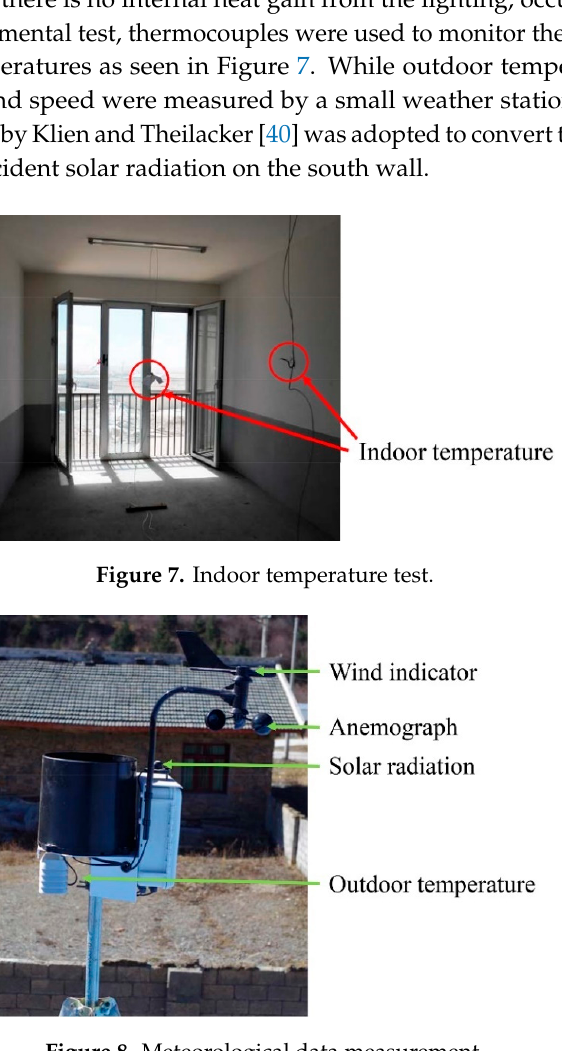
Figure 8. Meteorological data measurement.